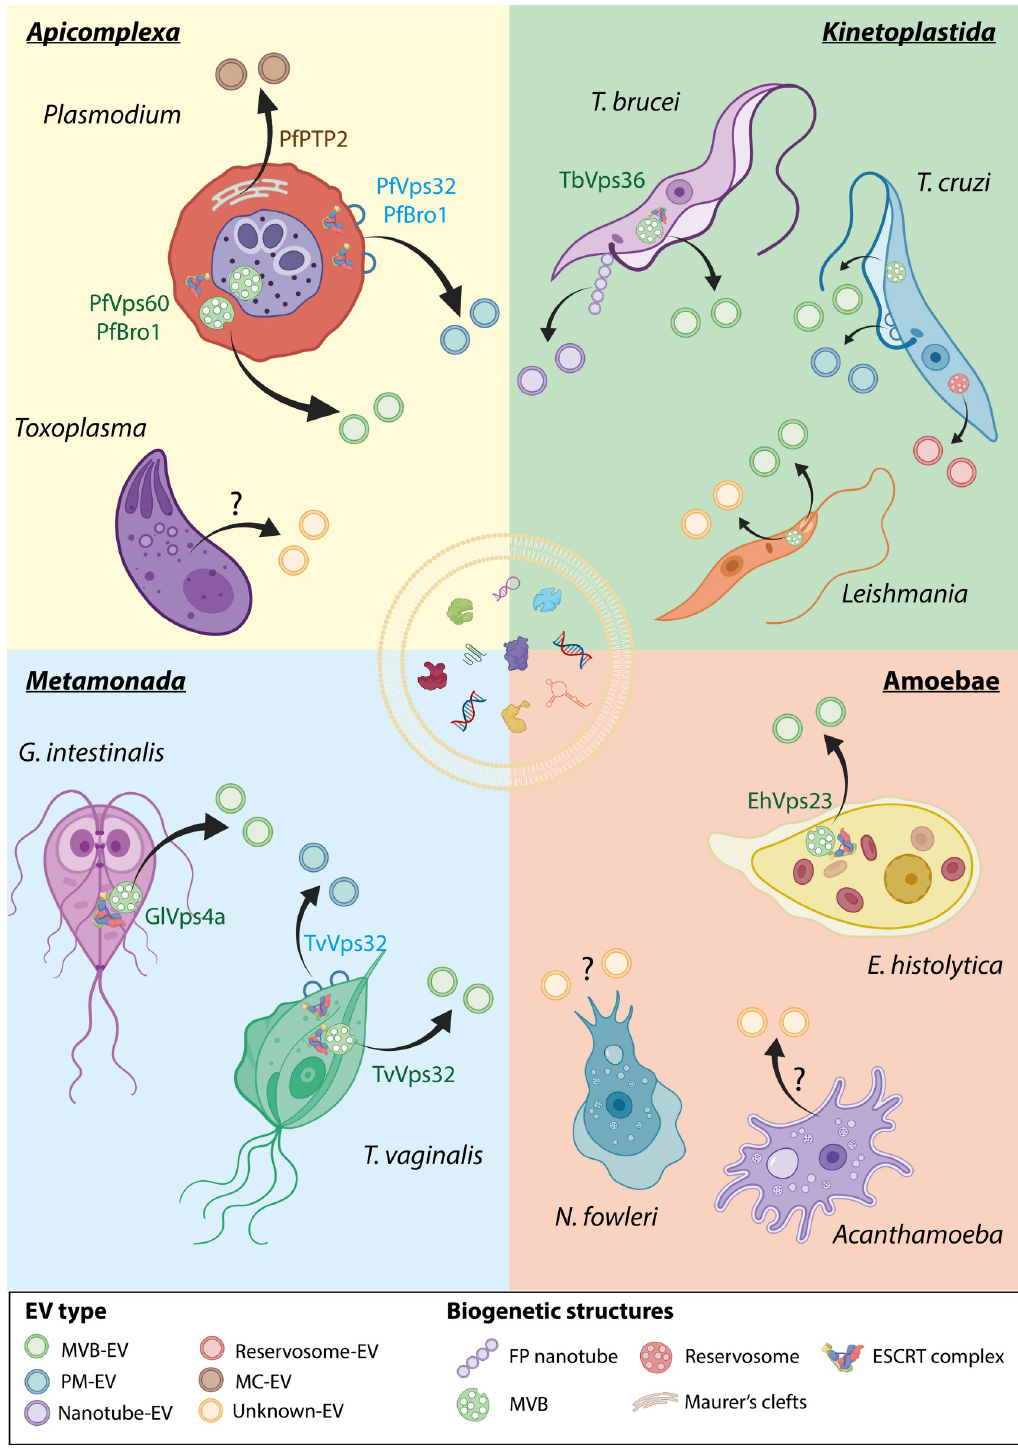
Fig 1. Overview of EV biogenesis and ESCRT protein involvement in human parasitic protozoa. The schematic diagram represents the current knowledge about EV biogenesis mechanisms in the most studied parasitic protozoa, organized by taxonomic and clinical proximity: apicomplexans, kinetoplastids, metamonads, and amoebae. The EVs’ colors reflect their biogenetic origins: MVB-derived exosomes (MVB-EV, green ), plasma membrane–derived ectosomes (PM-EV, blue ), nanotube- derived EVs (Nanotube-EV, purple ), reservosome-derived EVs (Reservosome-EV, red ), Maurer’s cleft-derived EVs (MC-EV,